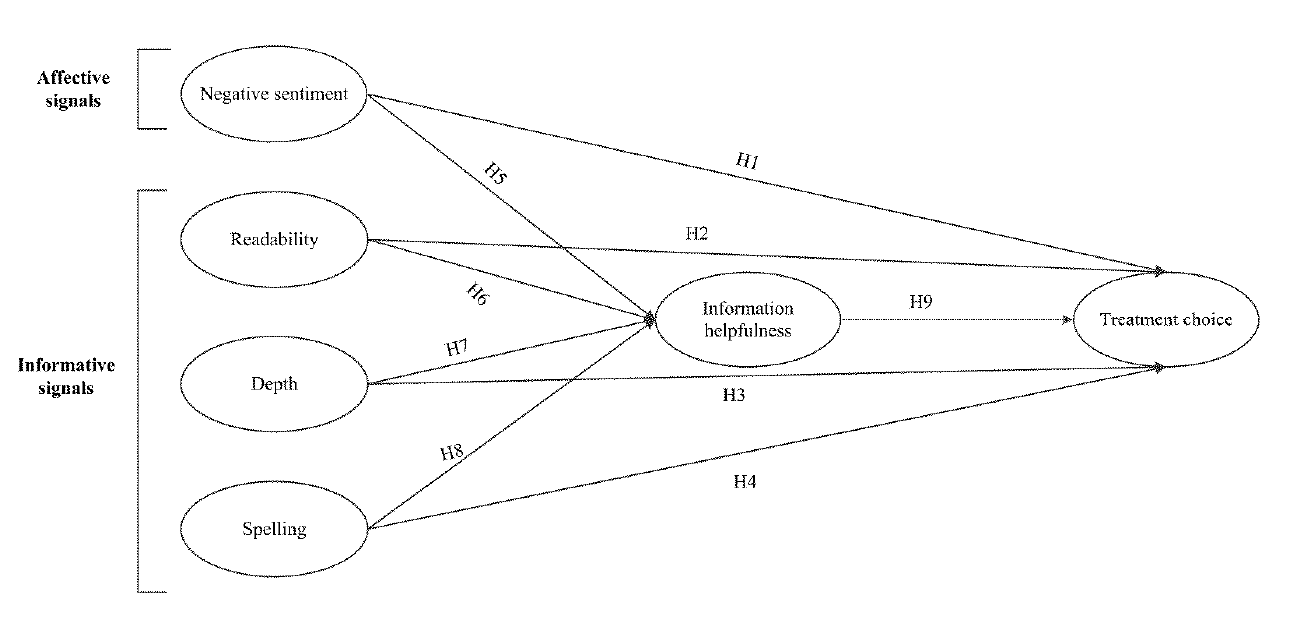
Figure 1. Research model.